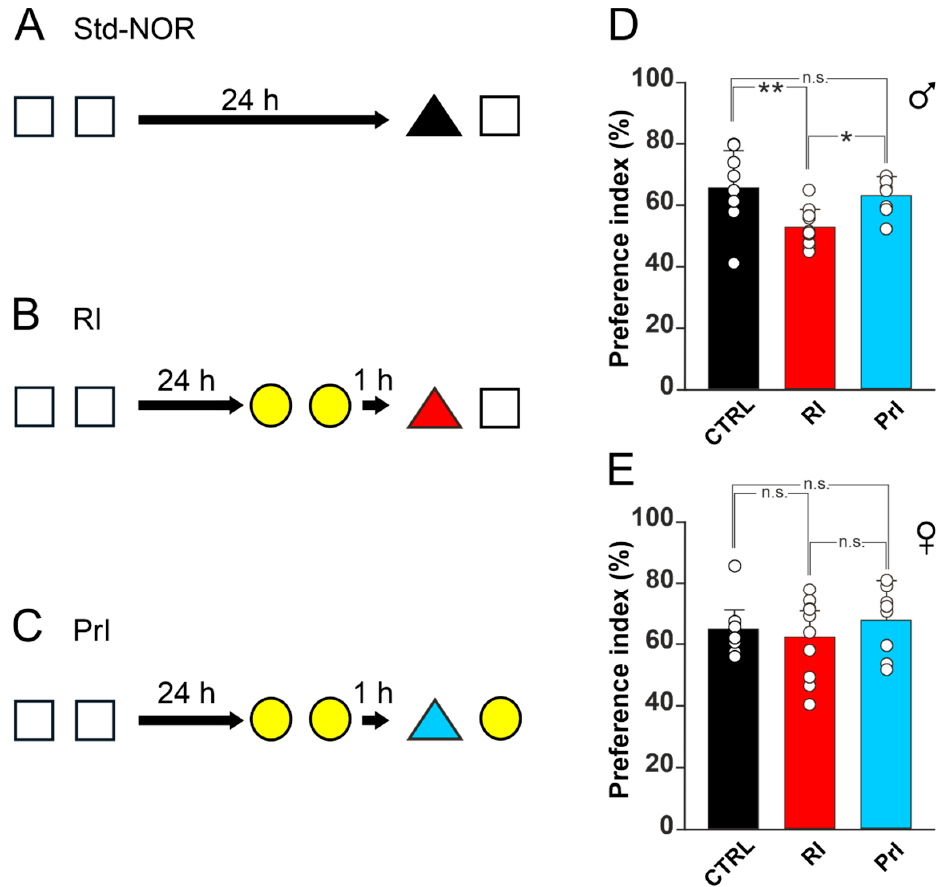
Figure 1. Female mice are resistant to retroactive interference. ( A – C ): Schematic representation of different object recognition memory paradigms used. Standard NOR procedure ( A ). Retroactive interference procedure (RI; ( B )). Proactive interference procedure (PrI; ( C )); white squares represent object 1, black triangle represents object 2, yellow circles represent object 3, red triangle represents object 4, and blue triangle represents object 5. ( D ): Histograms (mean ± SD) showing preference indexes for male mice undergoing Std-NOR, RI, and PrI. Asterisks indicate statistically significant differences between groups assessed by one-way ANOVA (F (2;25) = 6.731; p = 0.005; Std-NOR vs. RI p = 0.007, Holm–Sidak post hoc test; Std-NOR vs. PrI p = 0.604, Holm–Sidak post hoc test; Std-NOR n = 9; RI n = 11; PrI n = 8). ( E ): Histograms (mean ± SD) showing preference index for female mice undergoing Std-NOR, RI, and PrI. Asterisks indicate statistically significant differences between